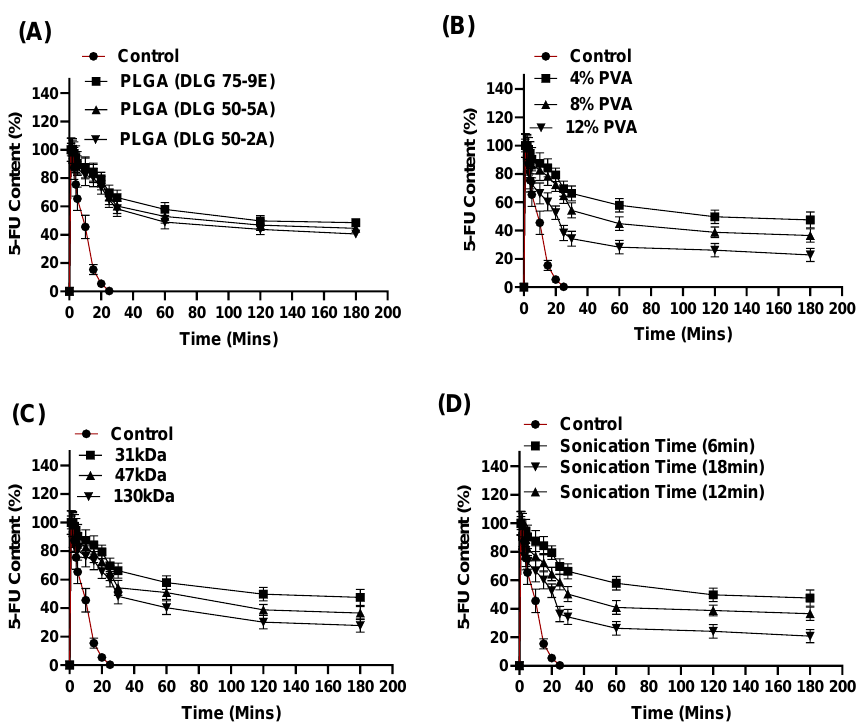
Figure 5. The influence of PLGA polymer (A), PVA loading (B), PVA molecular weight (C), and sonication time (D) on the 10% w/w 5-FU loaded nanoparticles to protect from degradation or engulfment from